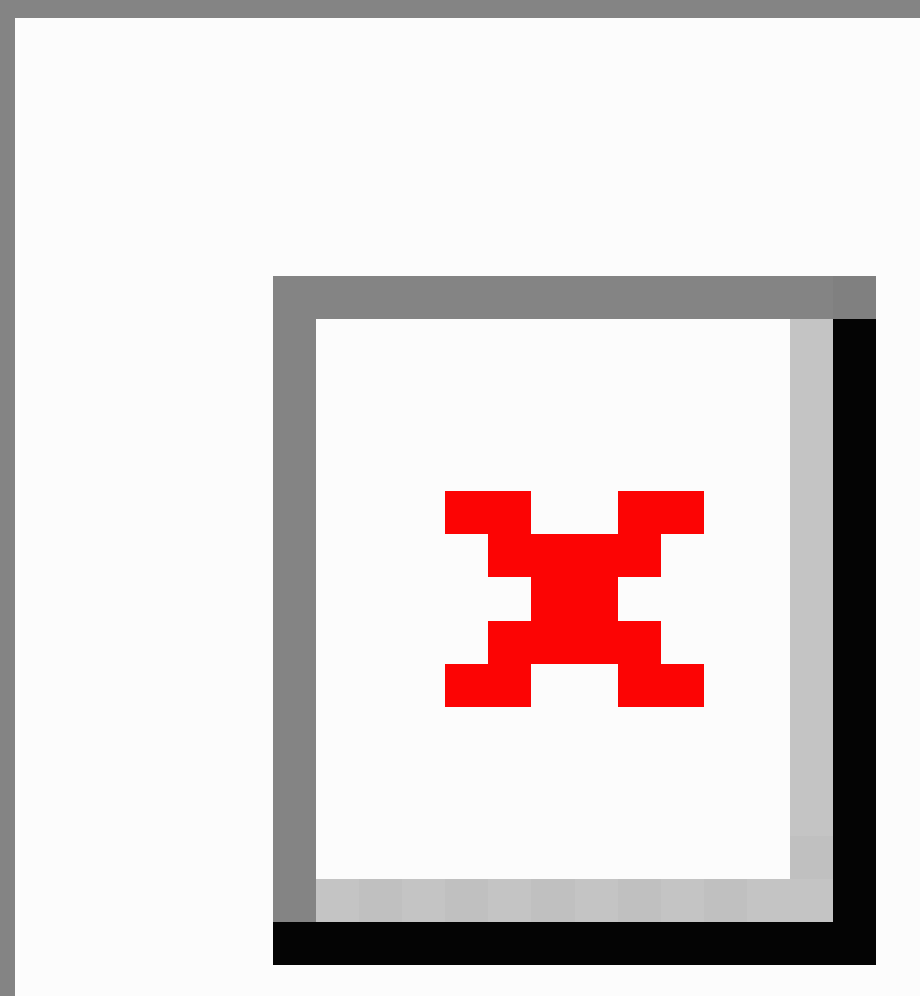
Figure 3. Event management system integrated within smartphone